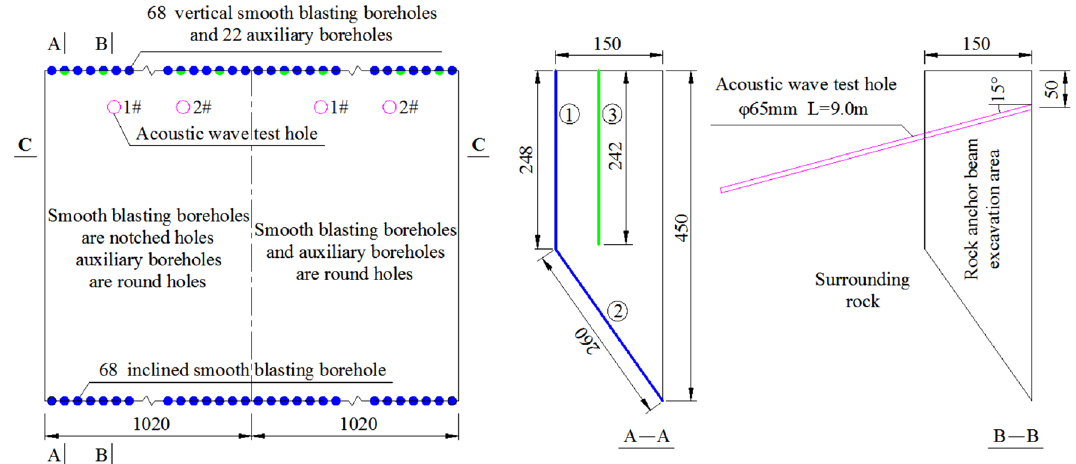
Figure 3. Borehole initiation circuit plan and borehole profile (unit: